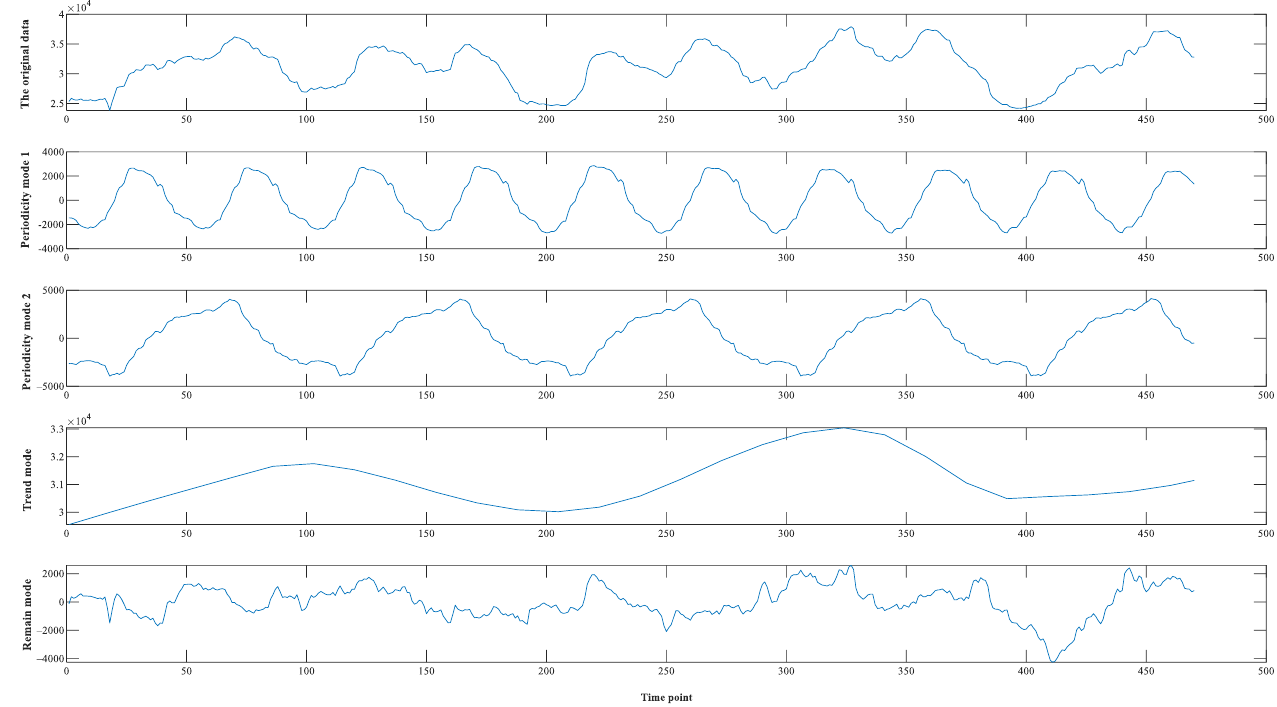
Figure 5. Decomposition modes obtained by IMSTL in the training dataset. Table 3. Data trait testing of each mode. Nature Trait The Importance of Each Pattern